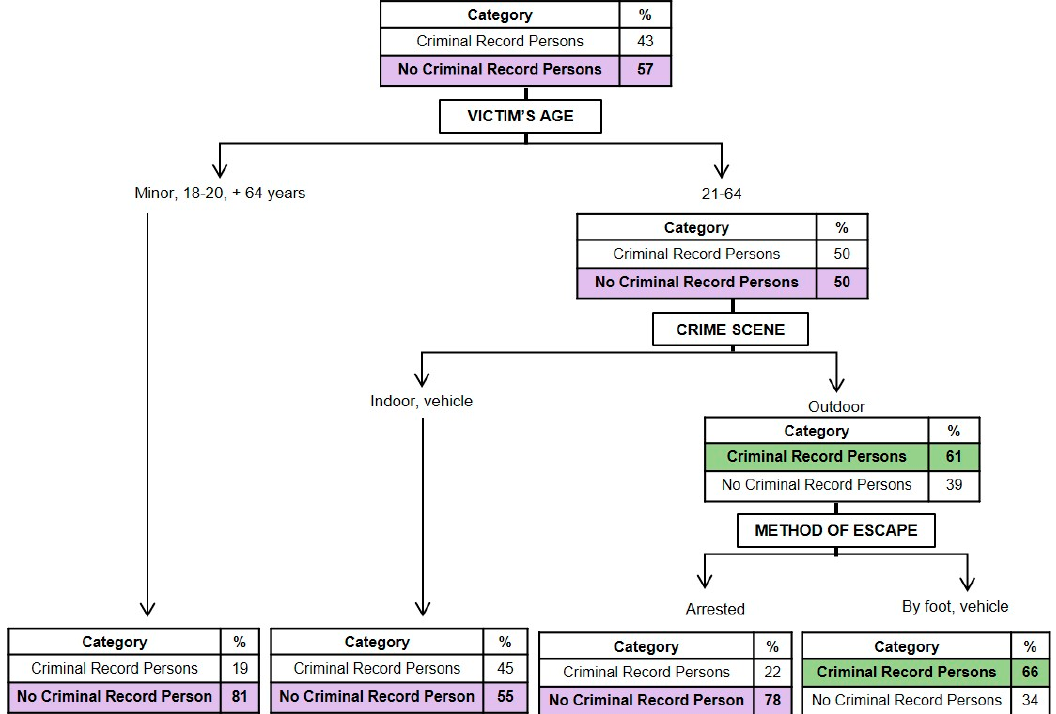
Figure 5. Graphical representation of the classification tree for the perpetrator’s criminal record of crimes against persons.